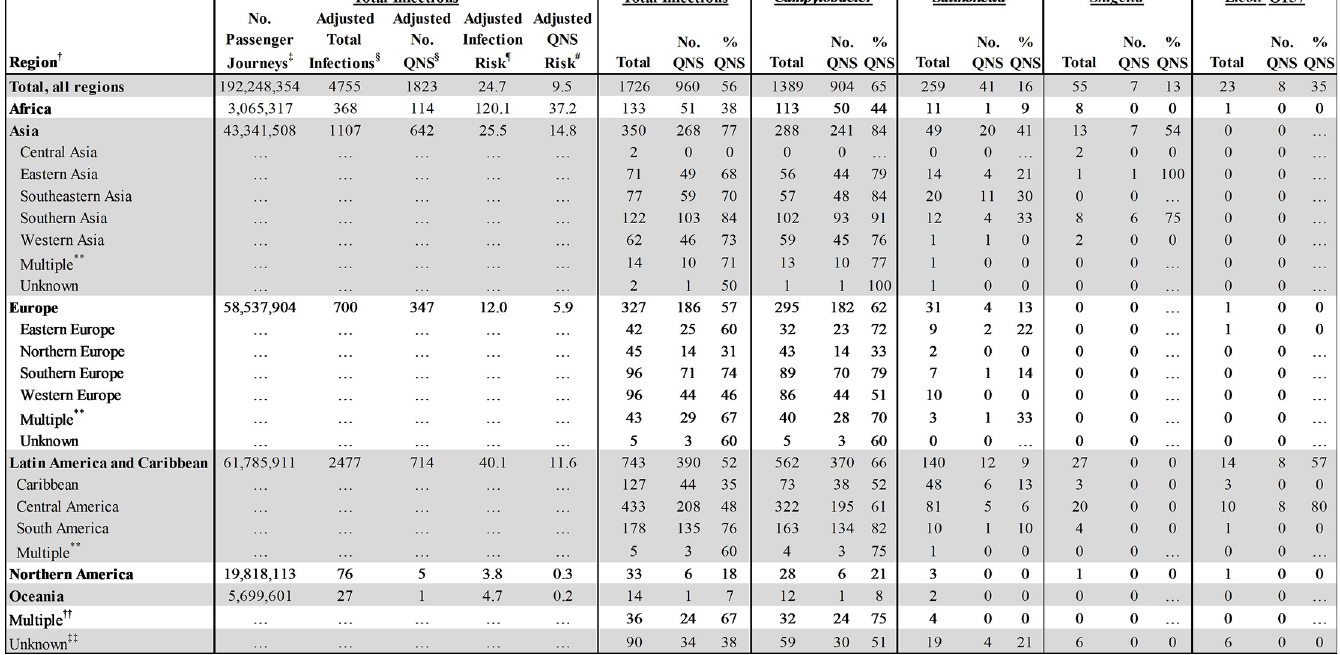
Fig 2. Number, percentage, and risk (per 1,000,000 air passenger journeys) of quinolone-nonsusceptible (QNS) infections in US travelers, by pathogen and region—Foodborne Diseases Active Surveillance Network and National Antimicrobial Resistance Monitoring System, United States, 2004–2014 � . � . Risk estimates were calculated for 2010–2014 because data about numbers of travelers to each region were not available for 2004–2009. †World Health Organization regions ( 9 ) ‡The estimated number of aviation passenger journeys on direct or multi-leg international flights terminating in the FoodNet catchment area during 2010–2014, as reported by the International Air Transport Association ( 10 ). Passenger journeys are not unique, individual travelers. Overland travelers were not included. §Number of travel- associated, and quinolone-nonsusceptible enteric cases during 2010–2014 adjusted to account for the NARMS sampling scheme by using a series of pathogen-specific multipliers. NARMS collects every 20 th NTS , Shigella , and O157 isolate, so we multiplied the number of cases with these infections by 20. For Campylobacter , the multiplier varied, according to the proportion of isolates submitted by site: we applied no multiplier if all isolates were submitted (Connecticut, Oregon, and Tennessee); multiplied by 2 if every 2 nd isolate is submitted (California, Colorado, Georgia, Maryland, and New York); multiplied by 3 if every 3 rd isolate is submitted (New Mexico); and multiplied by 5 if every 5 th isolate is submitted (Minnesota). ¶Adjusted risk of diagnosis with an enteric infection after return to the United States per 1,000,000 passenger journeys.#Adjusted risk of diagnosis with a quinolone-nonsusceptible infection after return to the United States per 1,000,000 passenger journeys. �� Case traveled to more than one sub-region in the same region. ††Case traveled to more than one region. ‡‡Travel destination was not